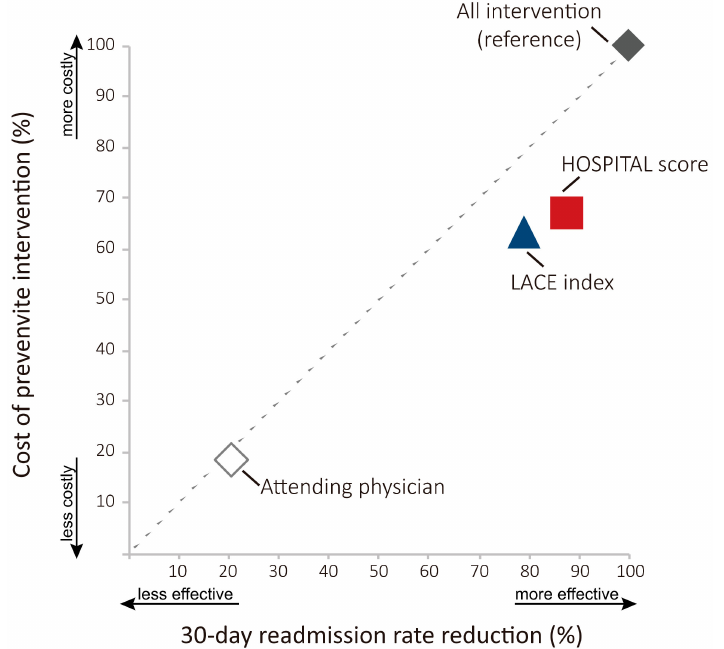
Figure 4. Cost-e ff ectiveness scatter plot of cost of preventive intervention against readmission by 30-day readmission rate reduction of the LACE index, HOSPITAL score, and attending physician models compared to the all intervention model (no prediction, a null model). A simulated result of acute hospitalizations of a home care patient cohort of a medical center a ffi liated home care unit in Taiwan, 2017 ( n = 87). The higher 30-day readmission rate reduction implies greater e ff ectiveness in reducing readmission, while the higher cost of preventive interventions implies more expense. The dotted diagonal line refers to equal cost and readmission rate reduction. Di ff erent data points denote di ff erent prediction models. Dots below the dotted diagonal line (right lower area) are deemed more e ffi cient than dots above the line (left upper